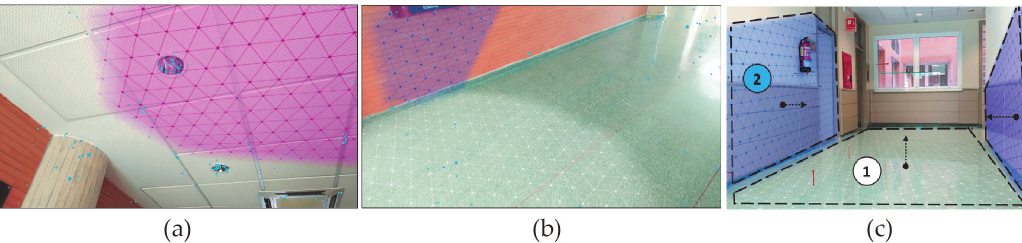
Figure 6. Plane surface tracking using ARCore: ( a ) horizontal surface scanning, ( b ) vertical surface scanning and ( c ) calculation of